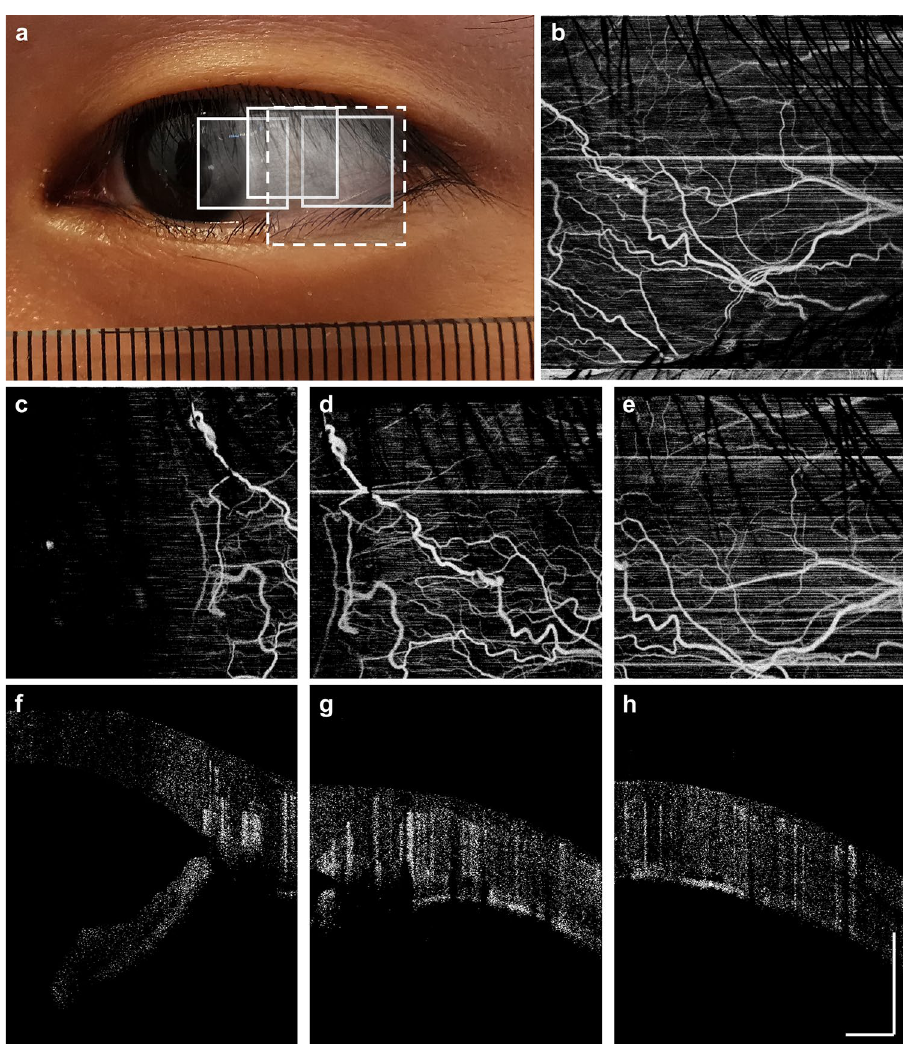
Figure 6. OCTA imaging using the SS-OCT prototype instrument. ( a ) Digital image of the subject. Boxes indicates locations of the OCTA scans. ( b ) 9-mm OCTA projection, scanned at the location corresponding to the dashed box. ( c )–( e ) 6-mm OCTA projections, scanned at locations corresponding to the solid boxes, respectively. ( f )–( g ) OCTA B-scans, extracted respectively from the center of the imaging field. Note the highly scattering sclera generates strong vertical projection artifacts. The OCTA signal posterior to the sclera is assumed to originate from the